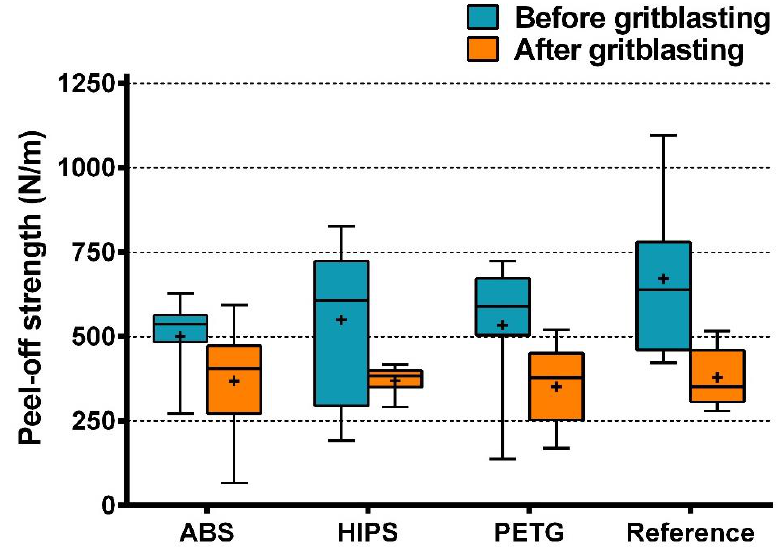
Figure 10. Peel-off strength of all material groups before and after GB (Boxplot, n = 11). + represents the mean peel-off strength of each group.